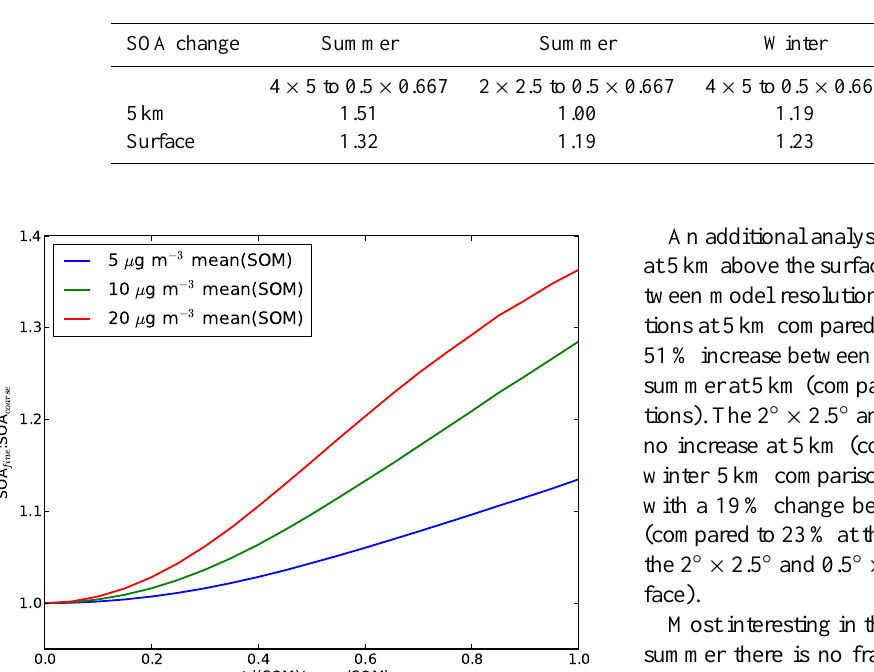
Table 2. A comparison of the 5km and surface SOA concentrations changes between different resolutions.